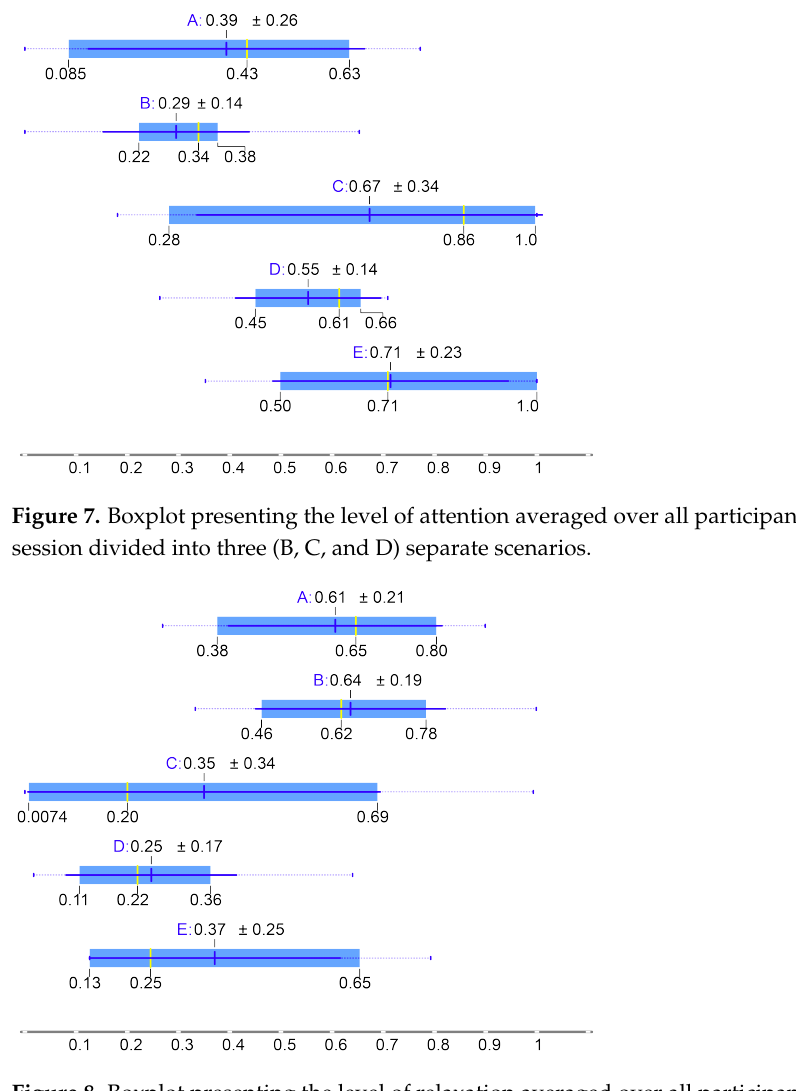
Figure 8. Boxplot presenting the level of relaxation averaged over all participants during the whole session divided into three (B, C, and D) separate scenarios.